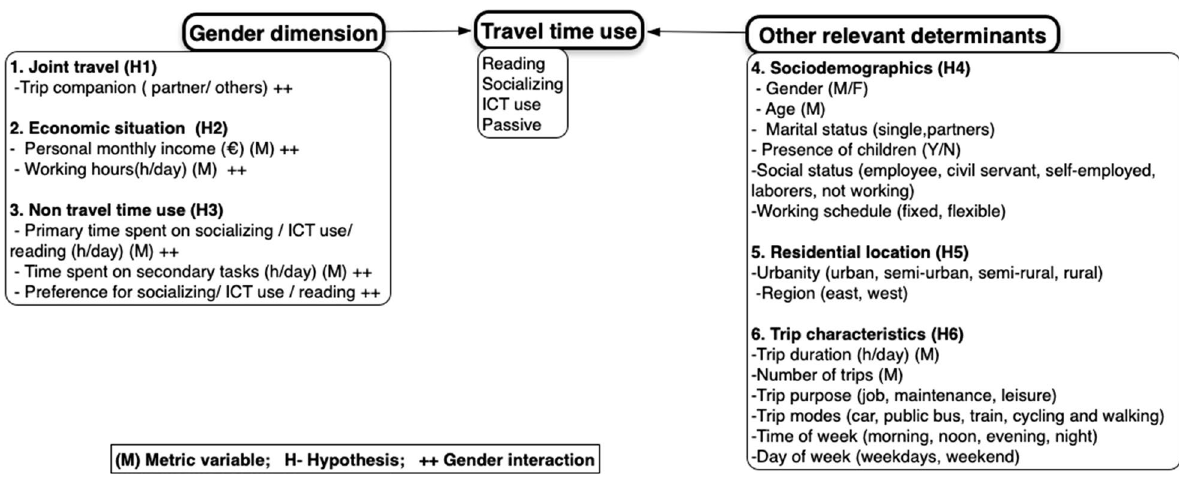
Fig. 1 Conceptual model of travel time use. Source : the